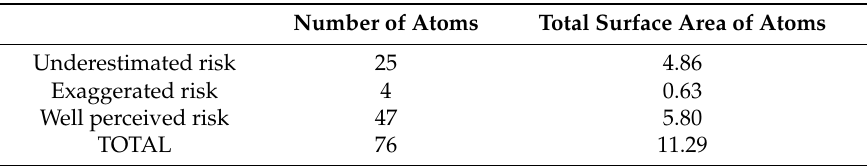
Table 1. Number of atoms with associated level of risk.